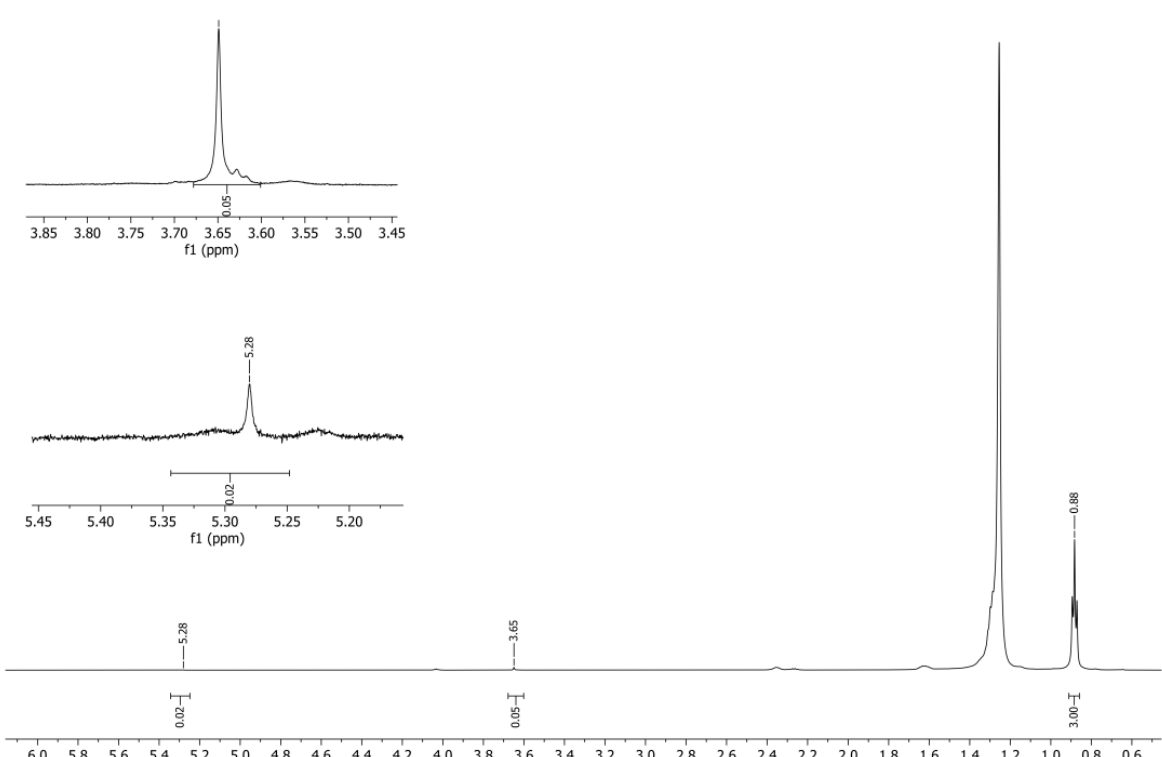
Figure 16. 1 H NMR spectrum for deoxygenated canola FAME product.